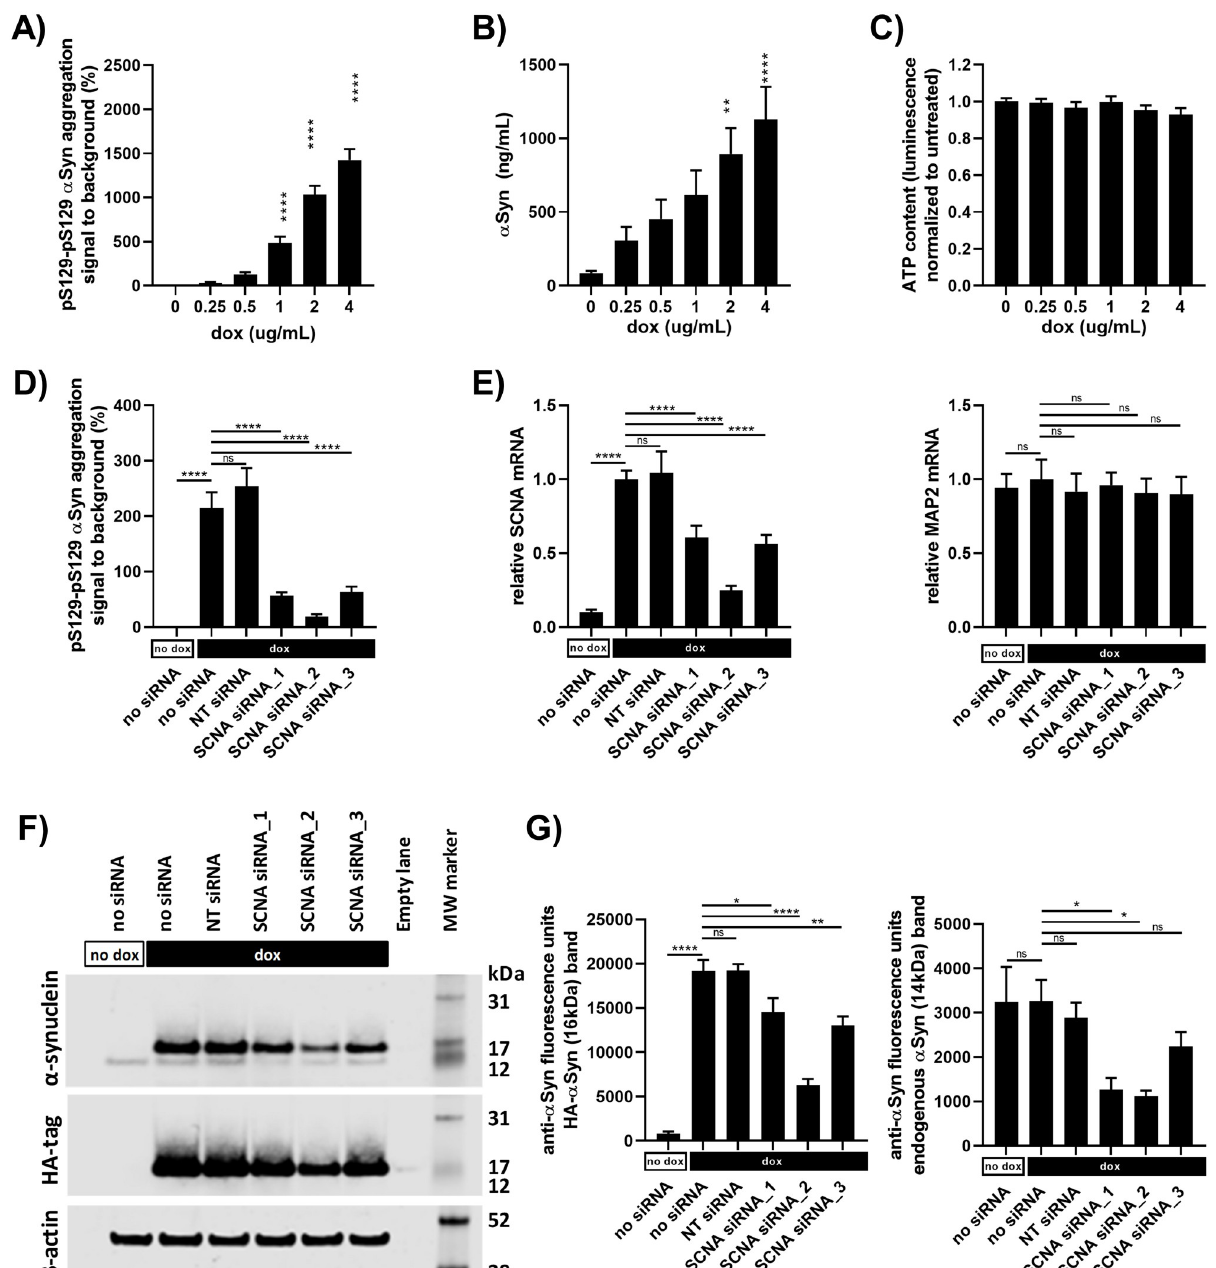
Fig 3. A53T α -synuclein seeding can be modulated. All graphs are shown as mean ± SEM, ns = non-significant, � p < 0.05, �� p < 0.01 and ���� p < 0.0001. (A) All samples were seeded with 0.1 μ g/mL fibrils91. FRET assays for pS129-pS129 α -synuclein aggregation showed a doxycycline-concentration dependent increase in the signal. (B) Electrochemiluminescence immunoassay showed a doxycycline-concentration dependent increase in A53T α - synuclein expression. (C) Measuring the cellular ATP content revealed no cytotoxicity from addition of 0.25–4 μ g/mL doxycycline. (D) All samples were seeded with 0.1 μ g/mL fibrils91. FRET assays for pS129-pS129 α -synuclein aggregation showed a doxycycline dependent increase in the signal, which was reduced by addition of SCNA siRNAs, but not a pool of four non-targeting (NT) negative control siRNAs. (E) Relative gene expression analysis confirmed knockdown of SCNA mRNA by the SCNA siRNAs but not the NT siRNAs. No MAP2 off-targets effects were seen. (F) Western blotting for α -synuclein and HA-tag. Representative blots of two experiments. (G) Quantification of α -synuclein blotting in F) confirmed a doxycycline dependent increase α -synuclein expression. Both wild-type endogenous α -synuclein (14 kDa) and HA-tagged A53T α -synuclein (16 kDa) were reduced by addition of SCNA siRNAs but not a pool of four non-targeting (NT) negative control siRNAs. Data in A), B) and C) were analyzed by one-way ANOVA followed by Dunnett’s multiple comparison test comparing to doxycycline untreated samples (n = 3, m = 6). Data in D), E) and G) were analyzed by one-way ANOVA followed by Sidaks’s multiple comparison test comparing the groups indicated with horizontal black bars (D. n = 3, m = 6; E. n = 3, m = 4; G. n = 2, m = 2). https://doi.org/10.1371/journal.pone.0261536.g003 PLOS ONE | https://doi.org/10.1371/journal.pone.0261536 December21, 2021 12 /